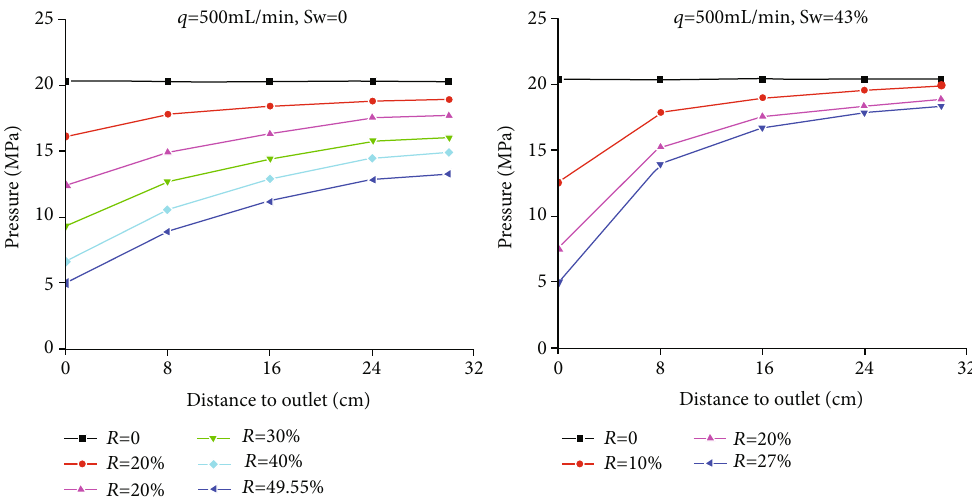
Figure 4: Comparisons of reserve utilization in the Su2 core under the dry and irreducible water